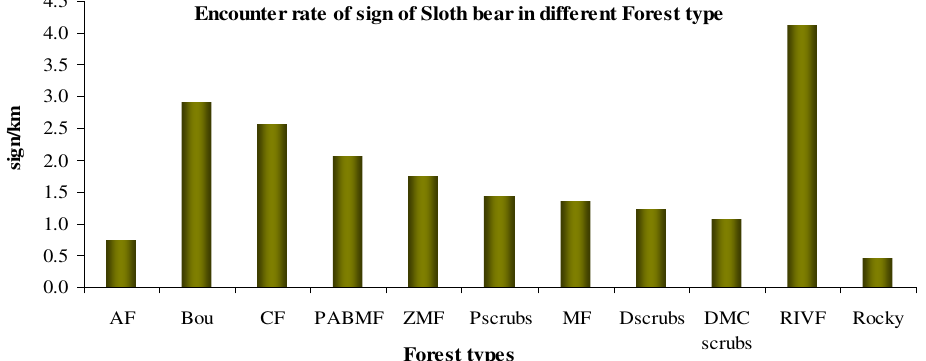
Fig. 3. Encounter rate of the sloth bear sign evidences in different forest types of the study area, AF= Acacia Mix Forest, Bou. = Boulders, CF= Crop Filed, DMC scrubs= Diospyros, Miliusa, Cassia scrubs, D scrubs = Diospyros scrubs, MF=Mix Forest, PABMF= Prosopis , Acacia, Butea , Mix Forest, P scrubs= Prosopis scrubs, RIVF= Riverine Forest, ZMF= Ziziphus Mix Forest